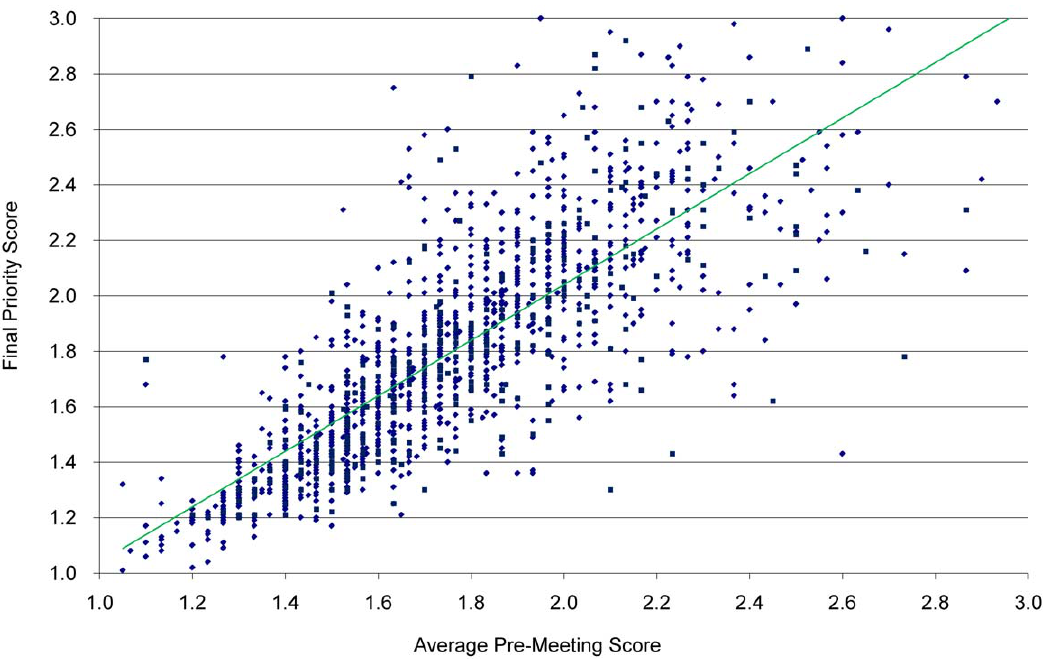
Figure 1. Average Preliminary Score versus SRG Final Priority Score. Preliminary Scores represent the average of the independent R01 priority scores given by the three assigned reviewers; the final priority score is the average of all the scores given by the voting members of the panel. Each data point represents the outcome for one R01 application. The difference between preliminary and final priority scores represents the change between the two values. Applications with differences displayed on the left declined after discussion; those on the right improved.